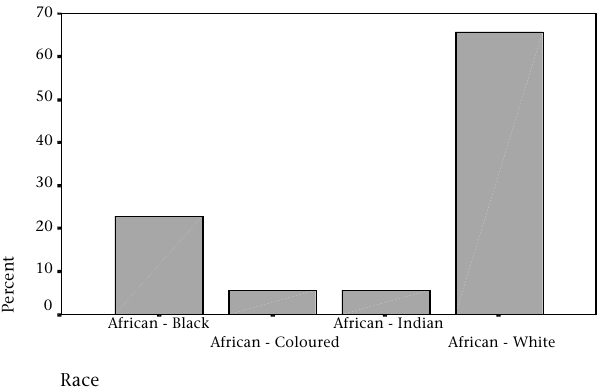
Figure 4: Race breakdown of SETA